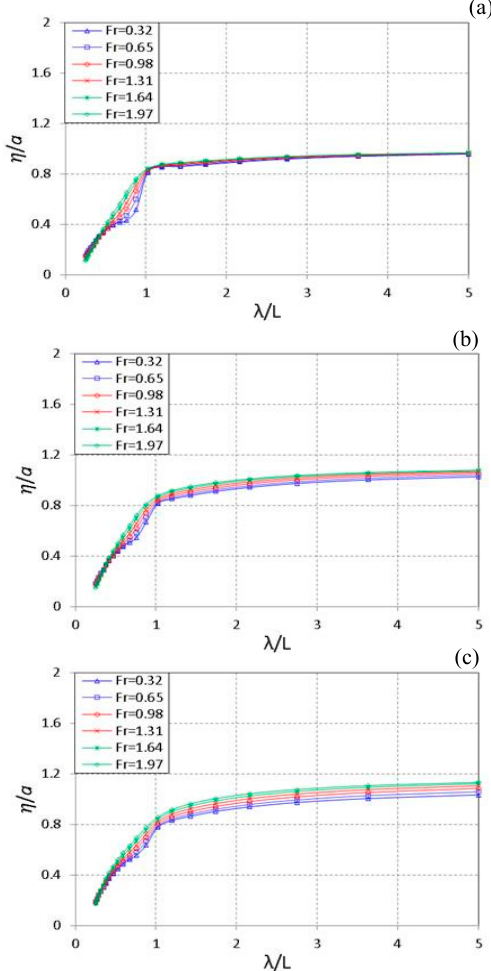
Figure 6. RAO comparison of swaying motion for various Froude numbers at μ = 90° corresponding to trim angles of ( a ) τ = 0°, ( b ) τ = 1°, and ( c ) τ = 2°, respectively.